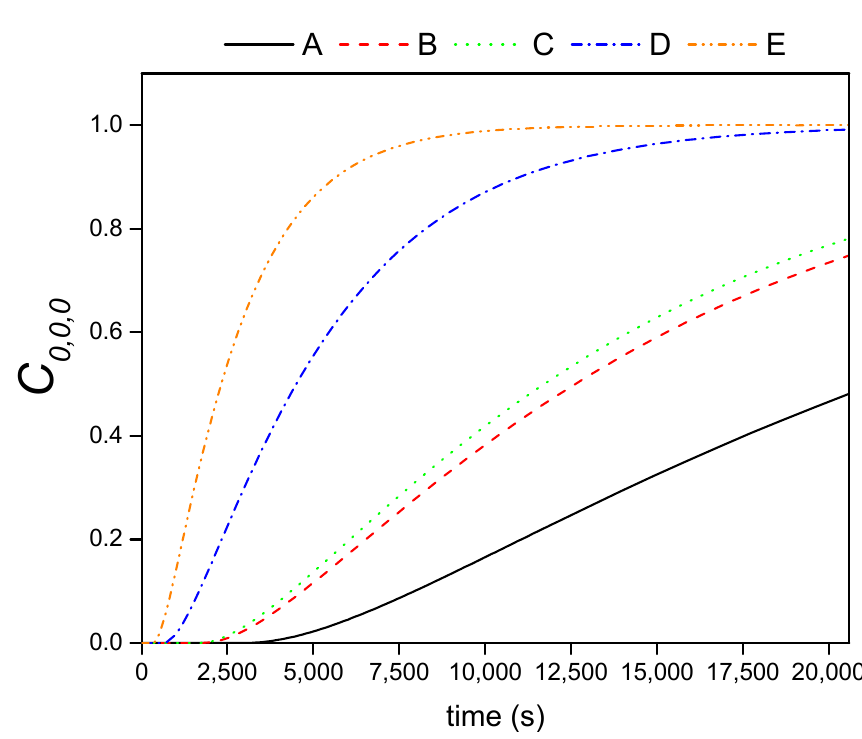
Figure 9. C 0,0,0 profile for the studied porous bricks.